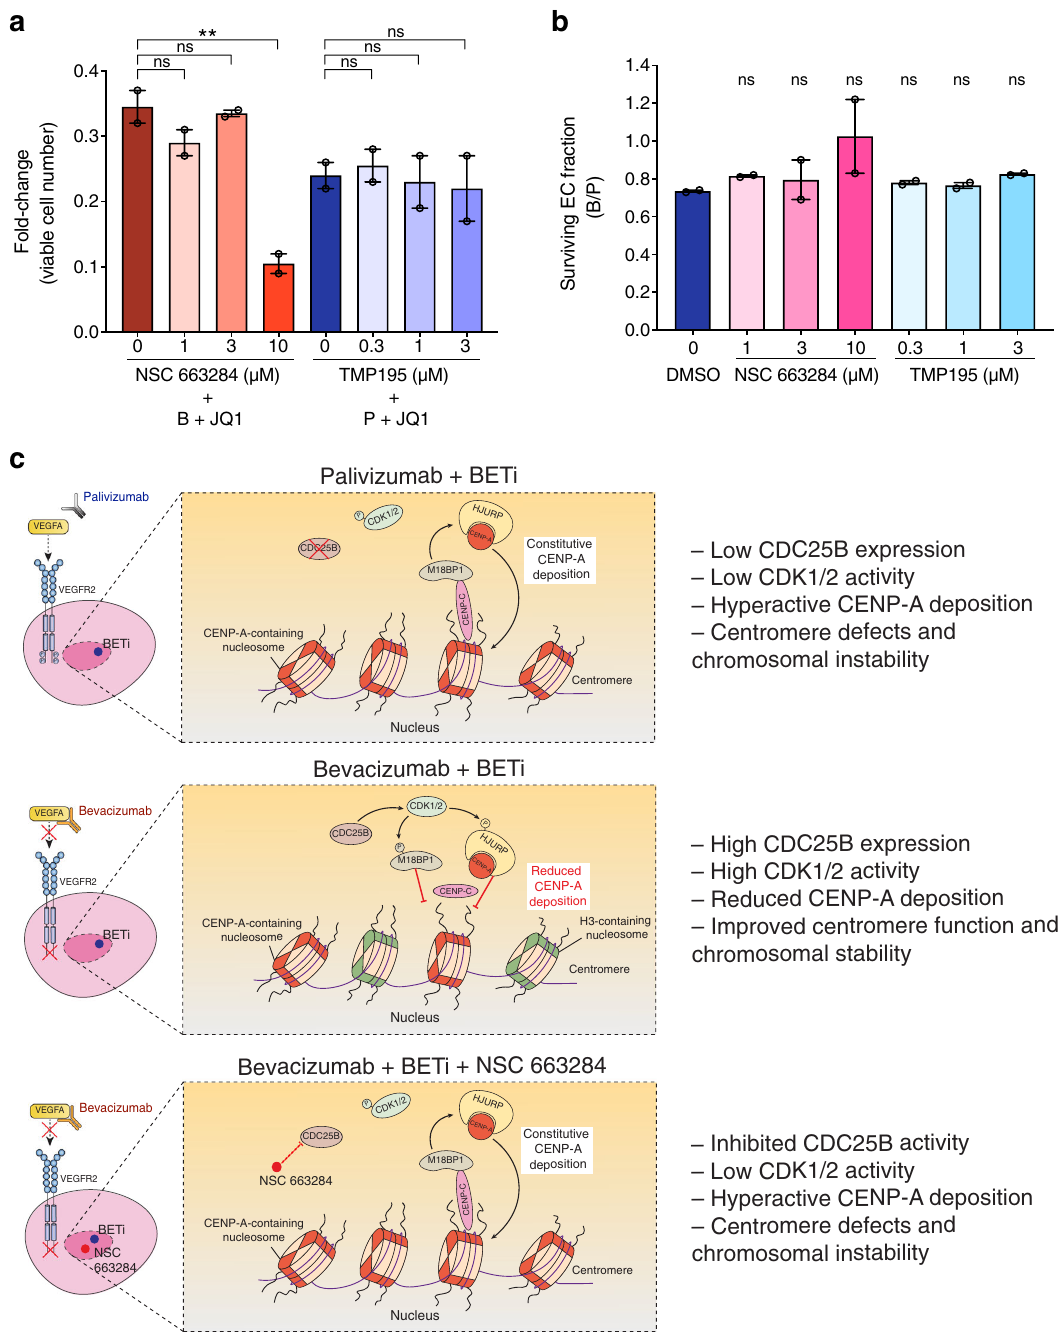
Fig. 7 CDC25B is associated with the altered EC response caused by co-treatment with BETi and bevacizumab. a Effects of NSC 663284 or TMP195 on survival and/or proliferation of ECs treated with JQ1 plus bevacizumab or palivizumab in ESFM. The addition of NSC 663284 at 10 µ M further reduced viable cell number in ECs treated with JQ1 plus bevacizumab while the addition of TMP195 did not affect those treated with JQ1 plus palivizumab. b Relative cell response to bevacizumab in ESFM plus DMSO, NSC 663284, or TMP195. The addition of NSC 663284 or TMP195 did not affect EC response to bevacizumab. Error bars represent ± SEM ( n = 2 independent experiments). **adjusted P value < 0.01; ns, not signi fi cant (versus B + JQ1, P + JQ1 or DMSO, one-way ANOVA with Dunnett ’ s multiple comparison test performed). c Schematic model illustrating a potential role for CDC25B in regulating the EC response to co-treatment with BETi plus bevacizumab. Top (palivizumab plus BETi), low CDC25B expression results in phosphorylated cyclin- dependent kinase (CDK) 1/2 and hyperactive centromere protein (CENP)-A deposition, which can cause centromere defects and chromosomal instability. Middle (bevacizumab plus BETi), upregulated CDC25B expression caused by co-treatment dephosphorylates and activates CDK1/2, which reduces CENP- A deposition by phosphorylating the M18BP1 and Holiday junction recognition protein (HJURP) complexes. Eventually, centromere function and chromosomal stability could be improved. Bottom (bevacizumab plus BETi plus NSC 663284), inhibition of CDC25B leads to low CDK1/2 activities in the presence of bevacizumab plus BETi. Reduced CENP-A deposition is therefore restored, which could result in centromere defects and chromosomal